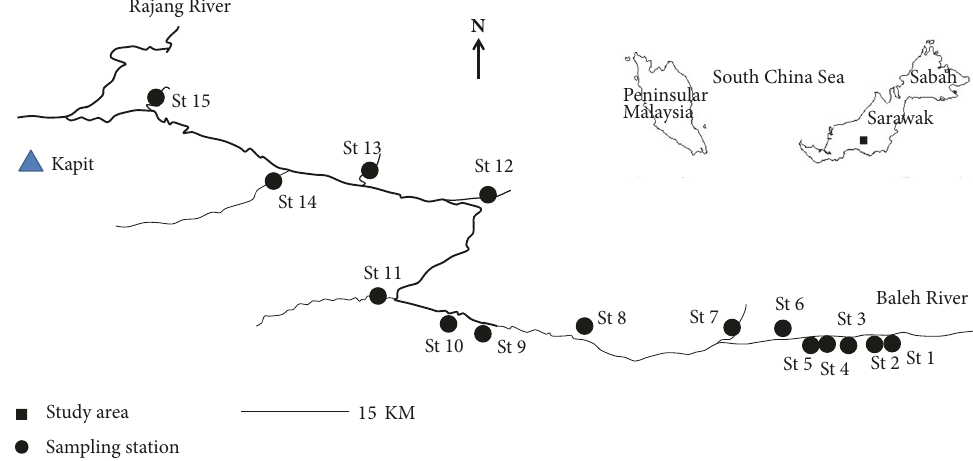
Figure 1: The study area and sampling stations in the present